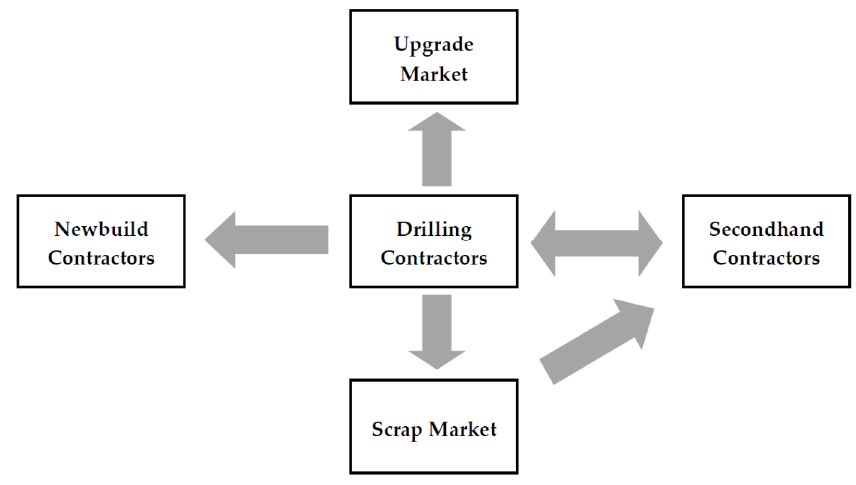
Figure 1. The five main markets of the drilling industry [6].